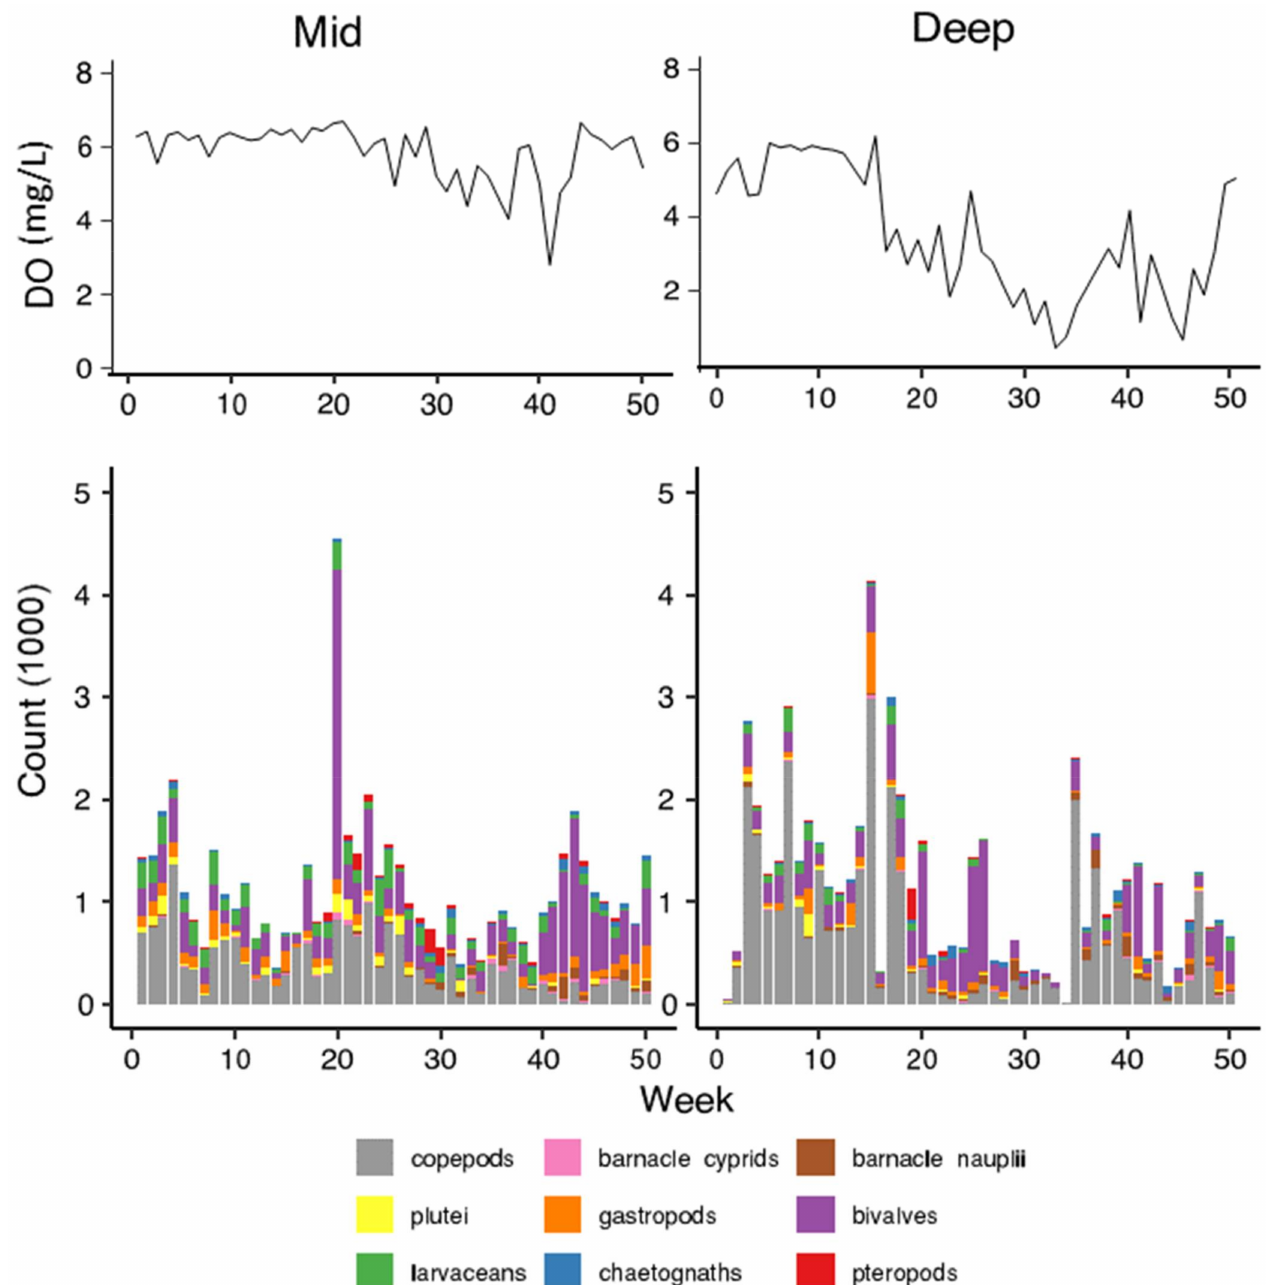
Figure 5. Dissolved oxygen and abundances of the nine focal plankton groups at Cristobal over the 50 weeks of this study, plotted by depth. Count values reported as 1000’s per 379 L